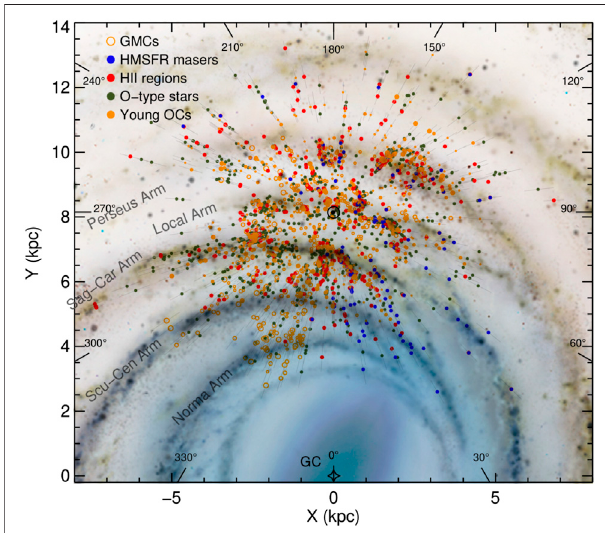
FIGURE 2 | Distributions of the combined dataset of GMCs (yellow circles),HMSFRmasers(bluedots),HII regions(reddots),O-type stars(green dots), and young OCs (yellow dots) are overlaid on a new concept map of the MilkyWay,whichiscreditedby:Xing-WuZhengandMarkReidBeSSeL/ NJU/CFA based on the spiral arm model of Reid et al.